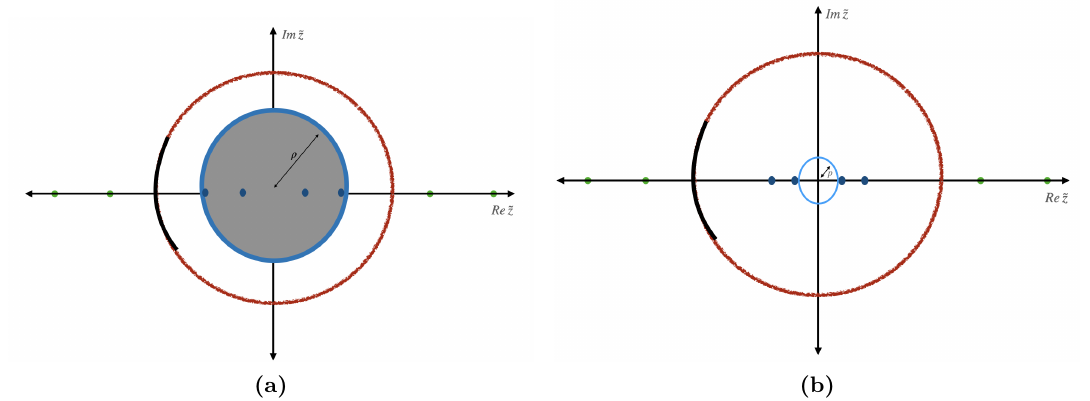
Figure 13. The image in the z -plane with branch cuts being mapped arcs on the boundary and poles being mapped onto [ − 1 , 1] with image poles being mapped outside the disk.The amplitude can now be treated as (a) An analytic function inside the annulus leading to the RNS bounds. Here ρ is the radius within which all poles are located. (b) A meromorphic function inside the disk leading to the Goodman bounds. Here p is the radius beyond which the massive poles are